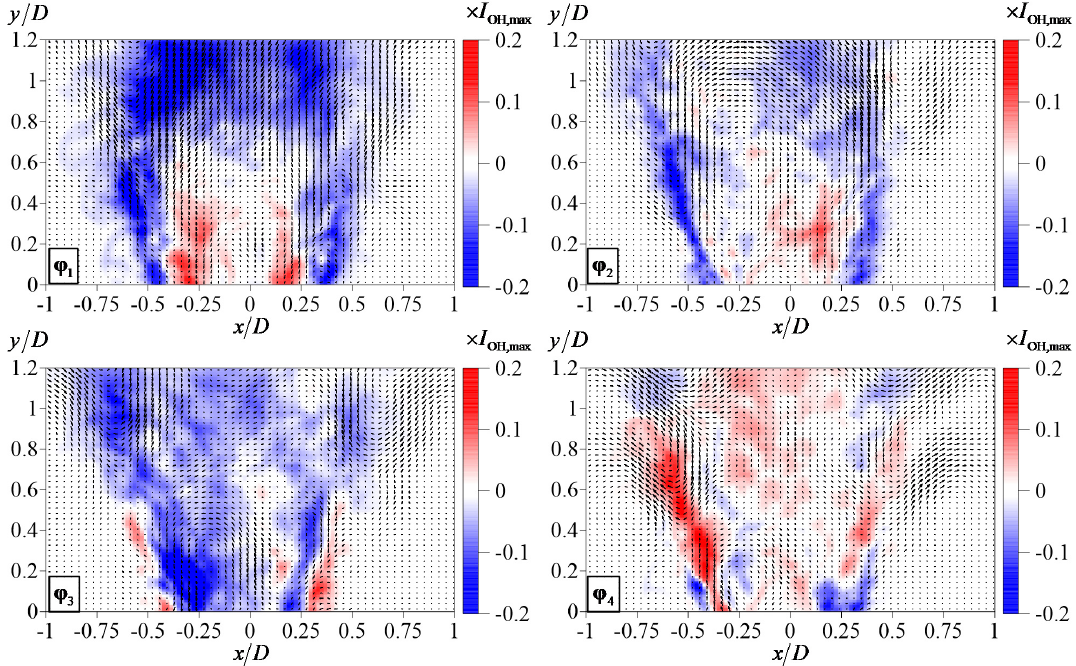
Figure 7. First four POD modes with phase-averaged OH PLIF intensity for methane flame at normal conditions.